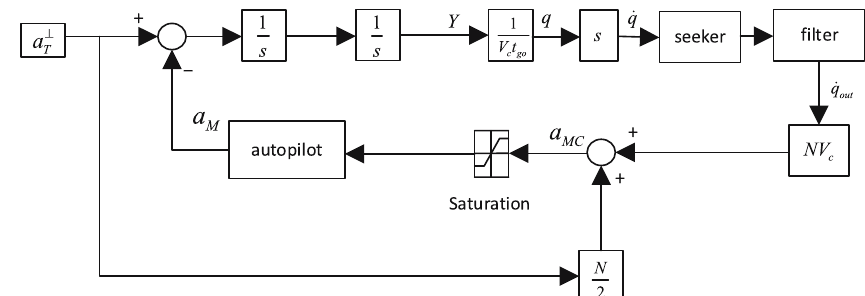
Figure 15: Linearized guidance system assuming no gravity.